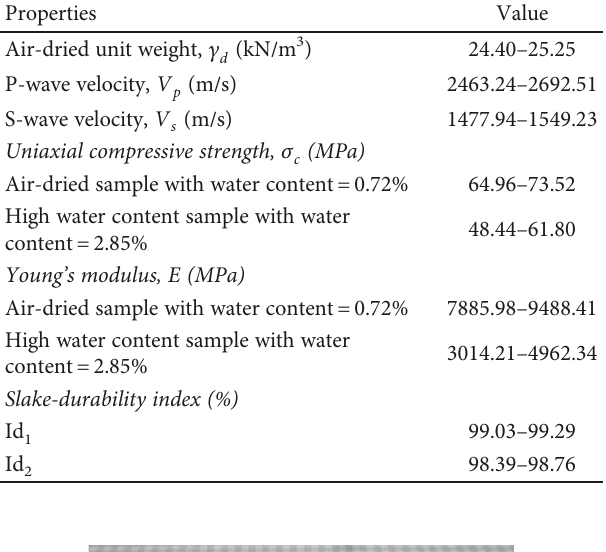
Table 2: Physical and mechanical properties of the Tangenshan